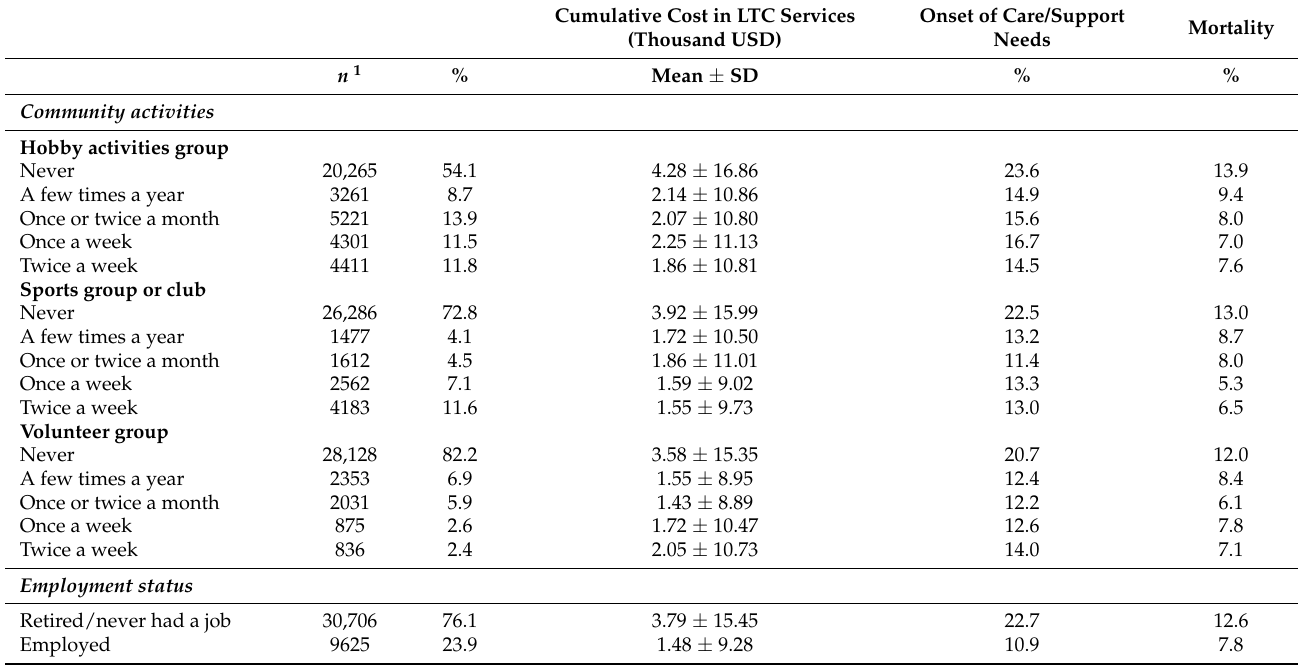
Table 1. Descriptive statistics of cumulative LTC service